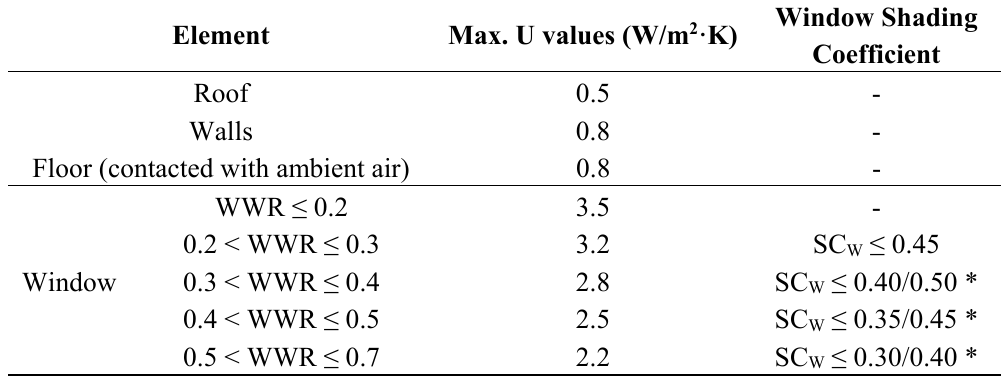
Table 2. Prescriptive window requirements defined by the DGJ08-107-20 code for Climate Zone Hot Summer/Cold Winter (Shanghai)